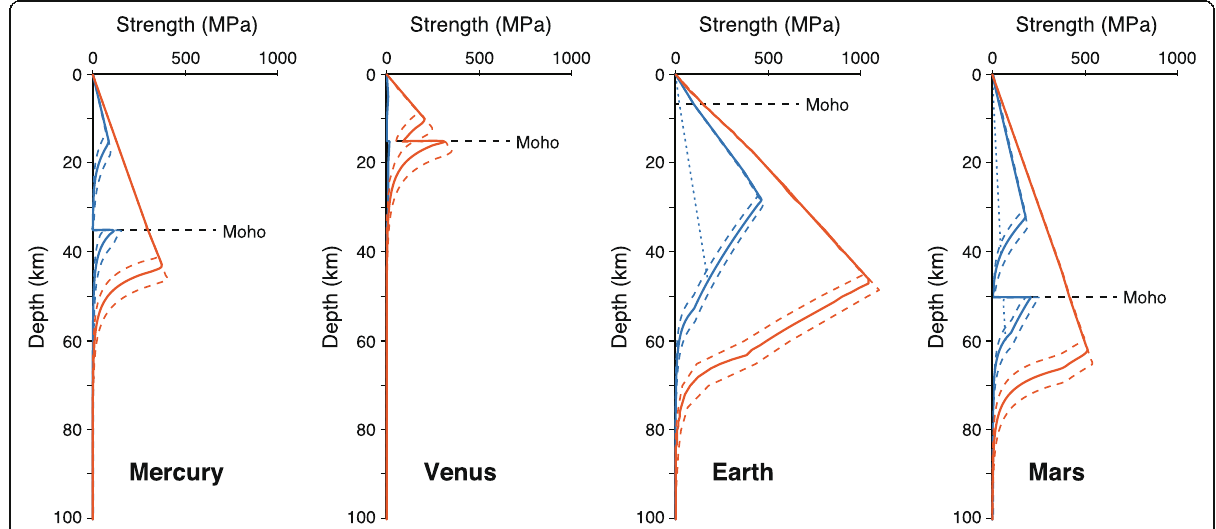
Fig. 3 Strength profiles for Mercury, Venus, Earth, and Mars calculated using a constant thermal gradient of 10 K/km and a constant strain rate of 10 − 17 s − 1 , under both dry (red lines) and wet (blue lines) conditions. Dashed lines indicate the influence of strain rate of 10 − 16 and 10 − 18 s − 1 , and dotted lines indicate the brittle strength in the presence of clay minerals. As plastic strength differs between crust and mantle, the strength profiles show a gap across the crust – mantle boundary (Moho) in case where deformation is